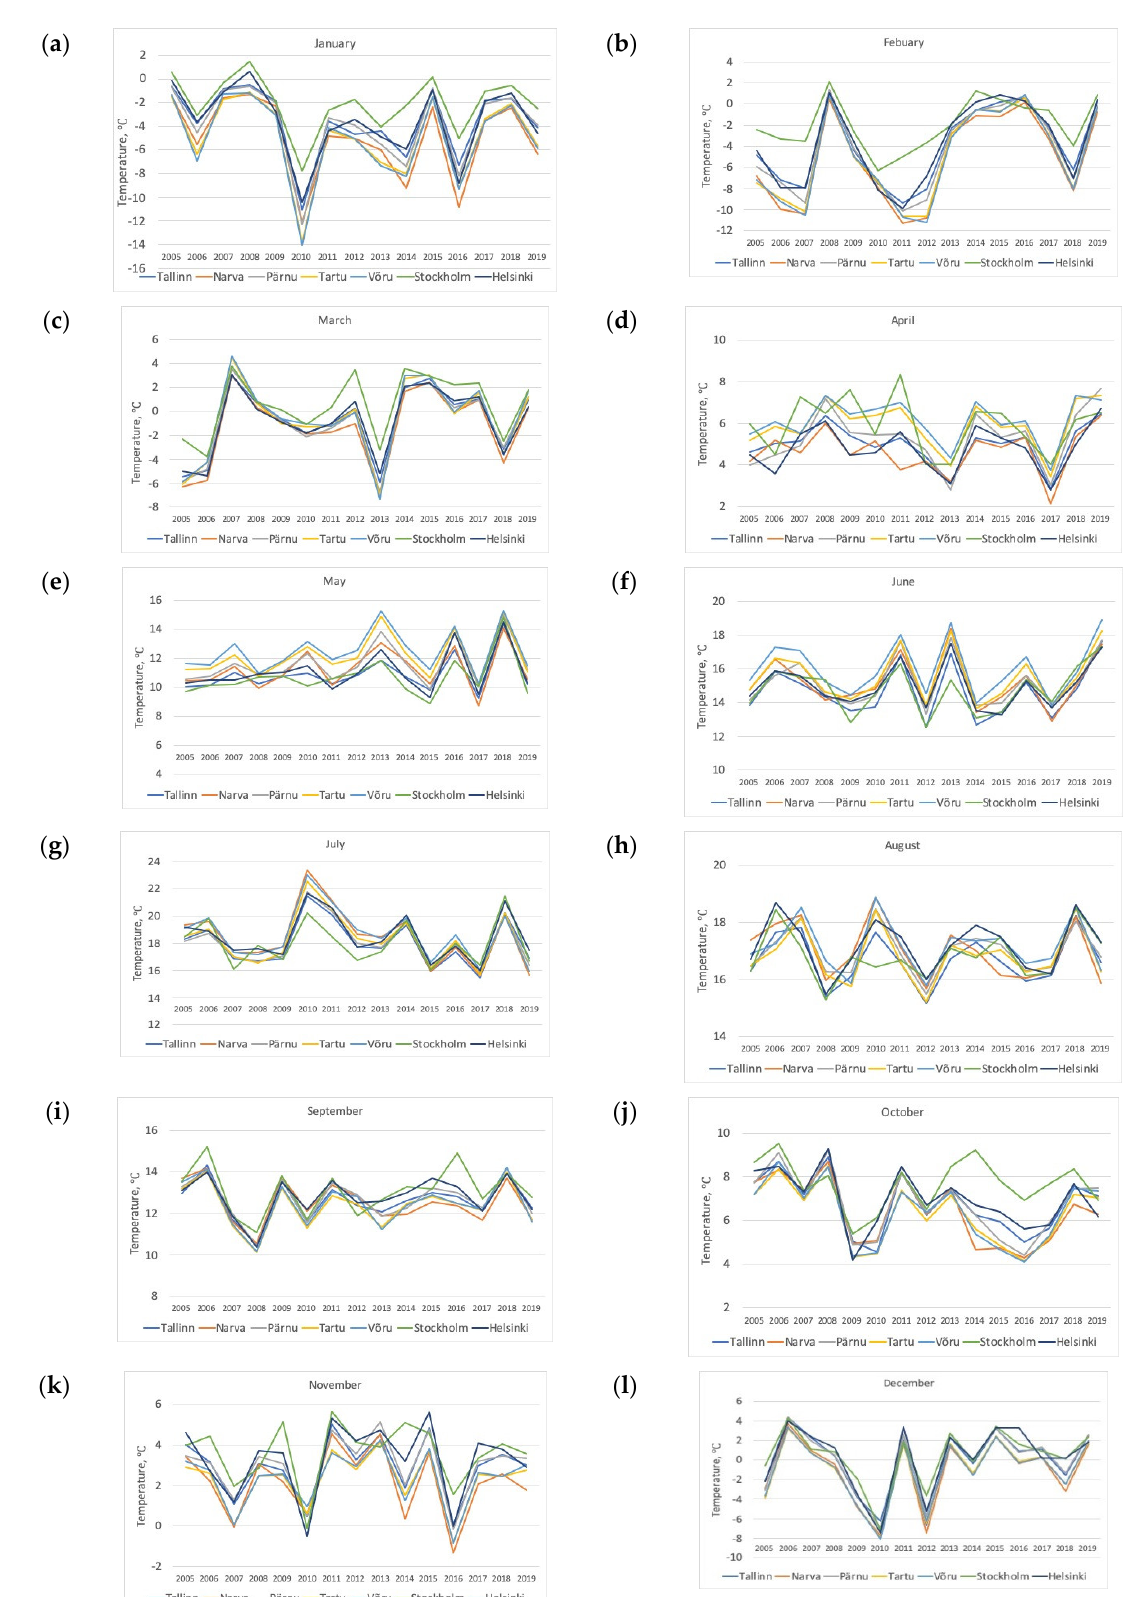
Figure 8. Changes in the average monthly surface air temperatures from 2005 to 2019: ( a )—January, ( b )—February, ( c )—March, ( d )—April, ( e )—May, ( f )—June, ( g )—July, ( h )—August, ( i )—September, ( j )—October, ( k )—November, and ( l )—December.